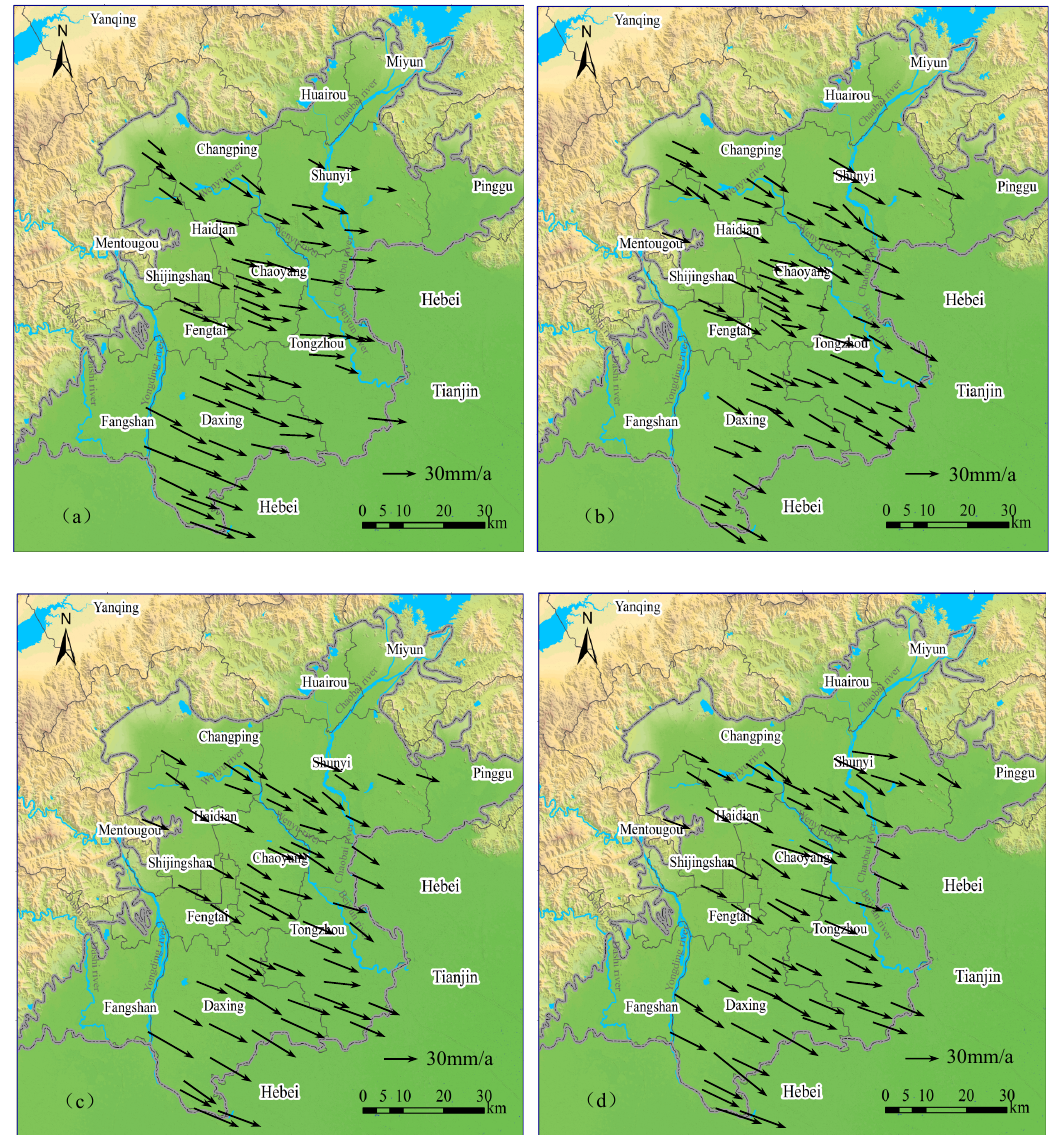
Figure 8. Horizontal velocity of GPS in Beijing Plain under ITRF2005 reference frame. ( a ) 2013~2015. ( b ) 2016. ( c ) 2017. ( d ) 2018.